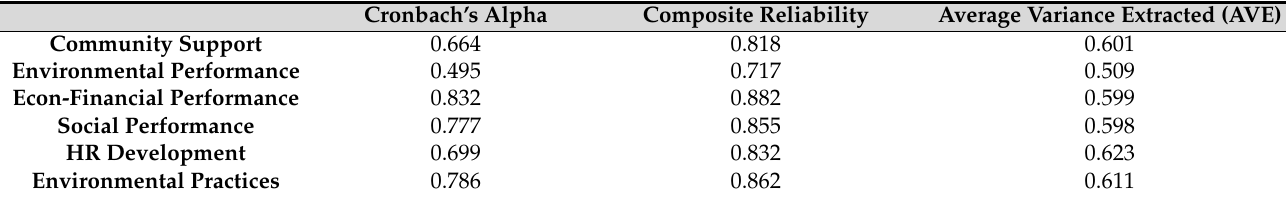
Table 8. Convergent Validity.